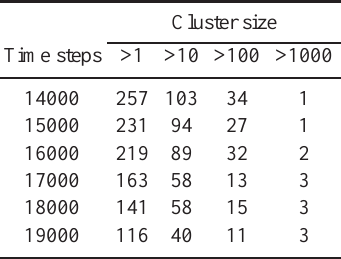
Table 2. Dependence of cluster distri- bution on the amount of time steps.